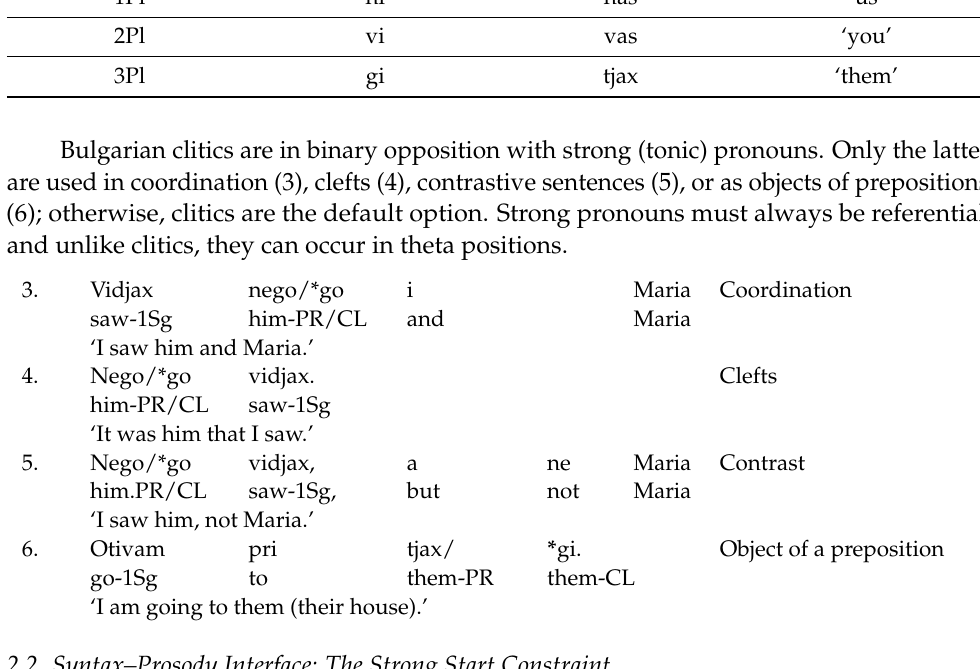
Table 1. Bulgarian direct object clitics and strong pronouns. Person/Number Object Clitics Strong Pronouns Translation 1Sg me mene ‘me’ 2Sg te tebe ‘you’ go (masc./neut.) nego (masc./neut.) ‘him/it 3Sg ja (fem.) neja (fem.) her’ 1Pl ni nas ‘us’ 2Pl vi vas ‘you’ 3Pl gi